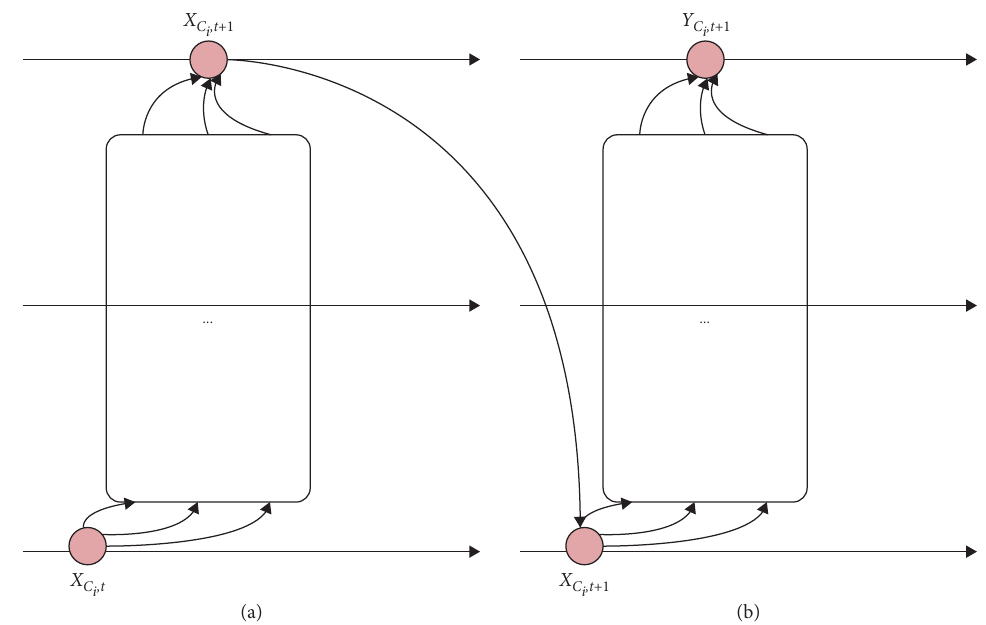
Figure 3: LSTM network for arrival and departure volume forecasts. (a) LSTM network for the arrival parking volume forecast. (b) LSTM network for the departure parking volume